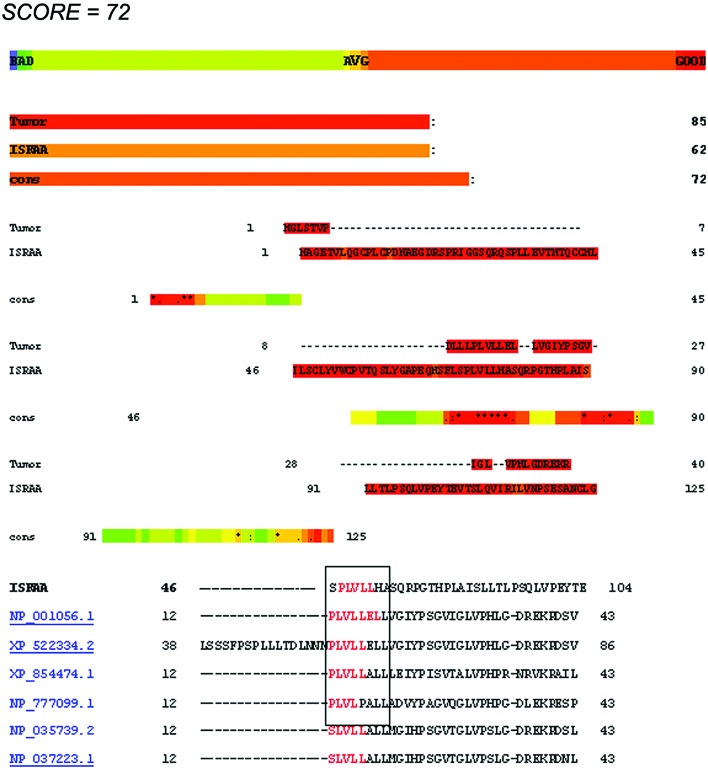
Alignment of ISRAA with TNFR1. The alignment of ISRAA with the SP motif of TNFR1 using T-Coffee Tool to determine the conserved regions revealed 72% similarity. ISRAA, immune system-released activating agent; SP, signal peptide; TNFR1, tumor necrosis factor receptor 1.